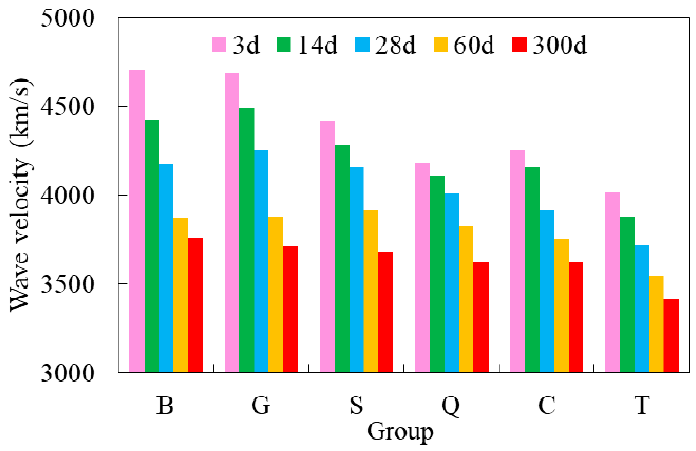
Figure 8. Results from ultrasonic non-destructive test.